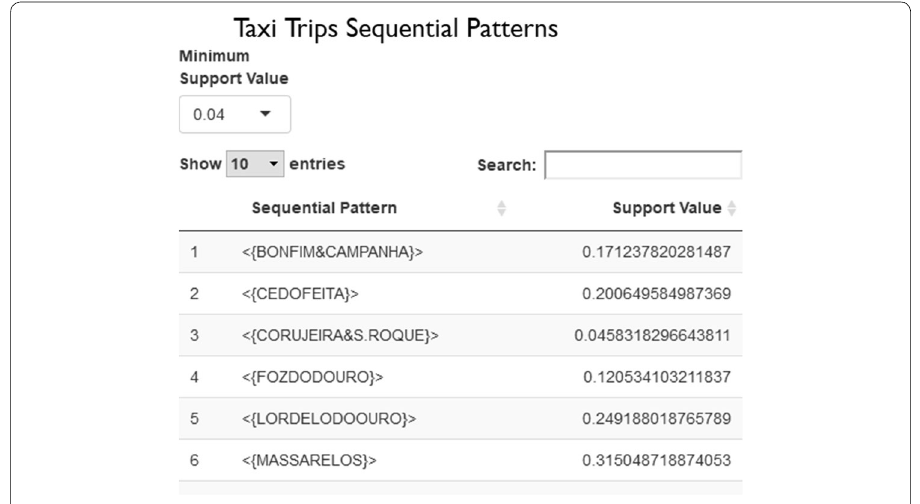
Fig. 15 R shiny slide for sequential pattern